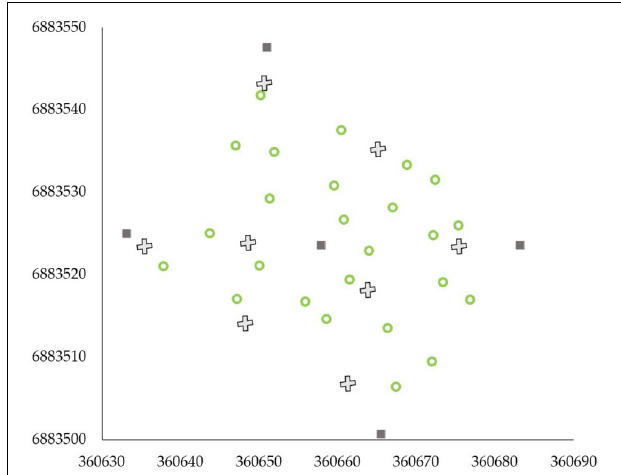
FIGURE 3 | Scan design of eight scans (denoted as X) per an example sample plot. Dark gray squares represent the plot corners and center and green circles trees within the plot. X and Y axes present the coordinates of the sample plot in ETRS-TM35FIN projected coordinate